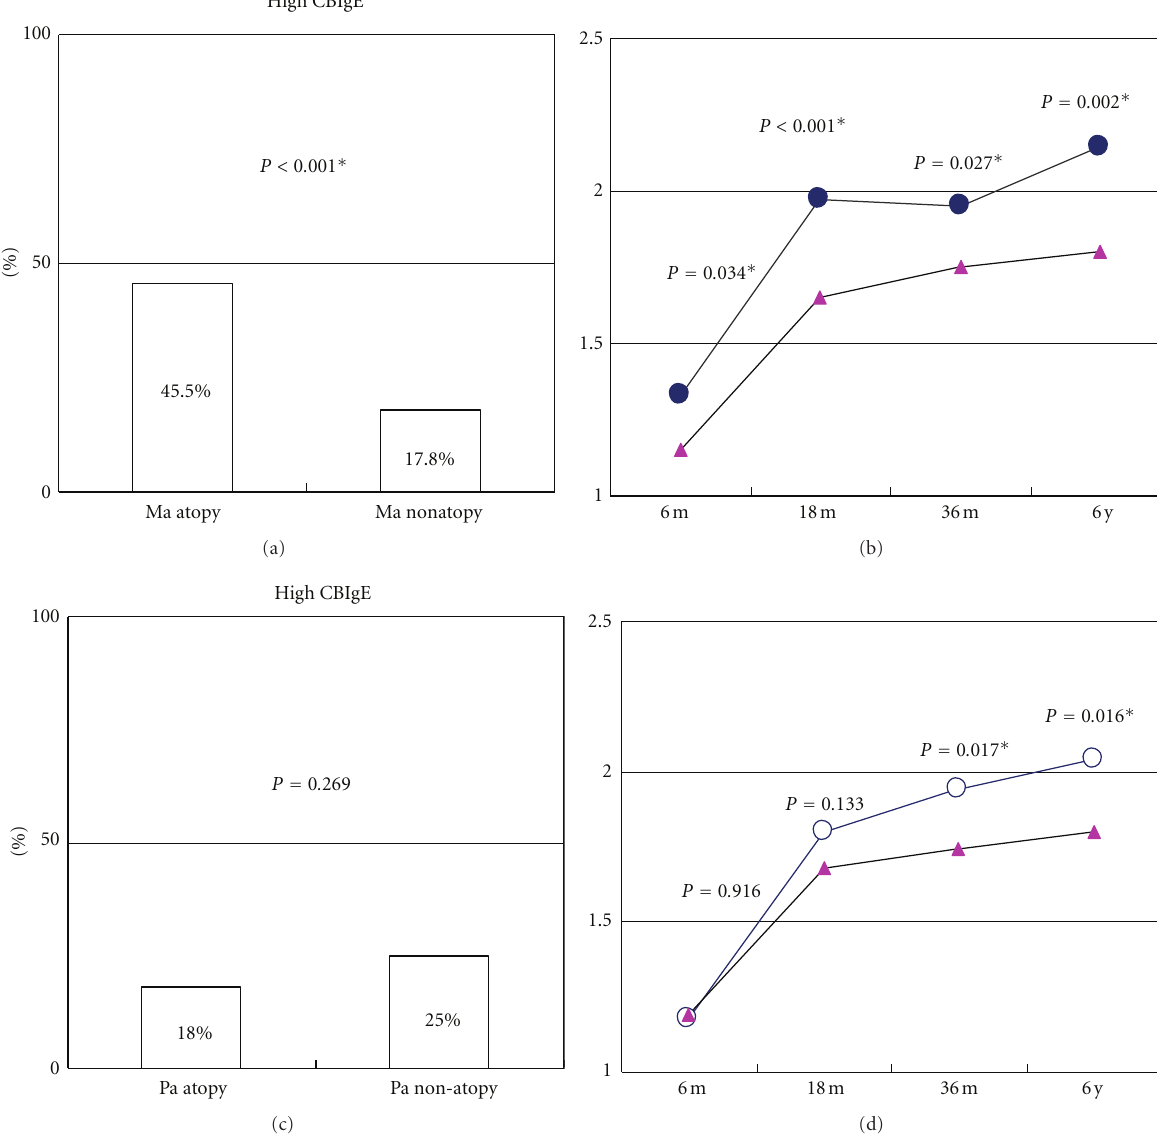
Figure 1: Di ff erent implications of maternal and paternal IgE levels for antenatal IgE level and postnatal IgE production at di ff erent ages in our cohort study. (a), (c): Maternal (Ma) atopy, defined as IgE > 150 kU/L, but not paternal (Pa) atopy, significantly a ff ected antenatal IgE production, reflected by CBIgE elevation ( > 0.5kU/L). (b), (d): Maternal atopy (solid circles) was significantly associated with log-trans- formed IgE levels at 6 months (6m), 18 months (18m), 3 years (36m), and 6 years (6y) of age, whereas paternal atopy (open circles) was only significantly associated with log-transformed levels at 3 and 6 years of